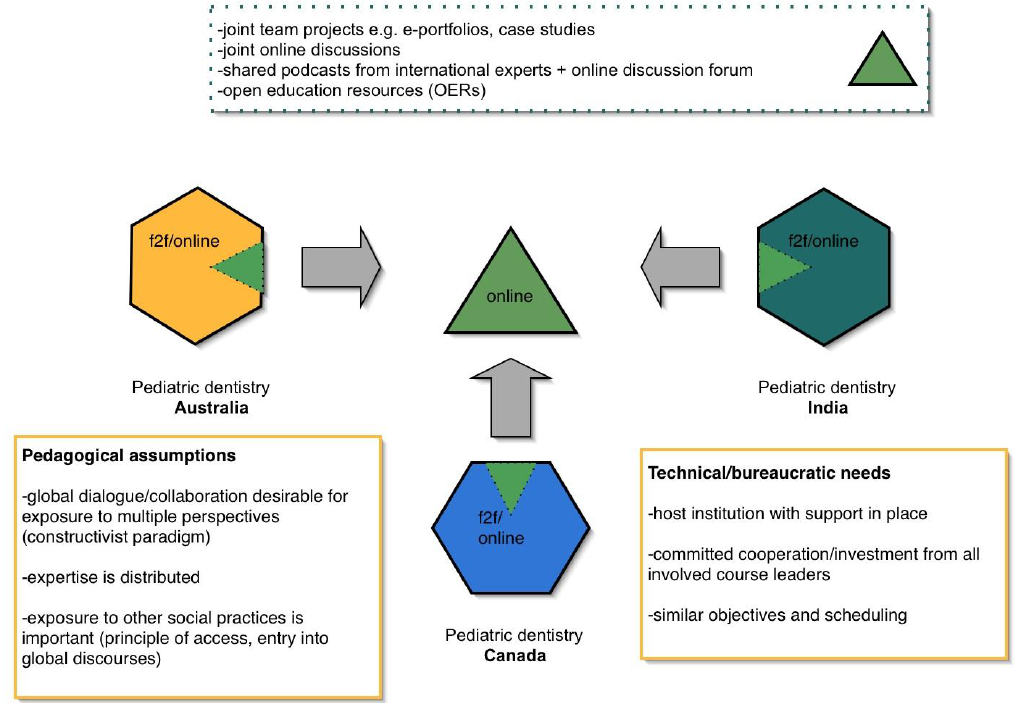
Figure 2. Open model for inter-university